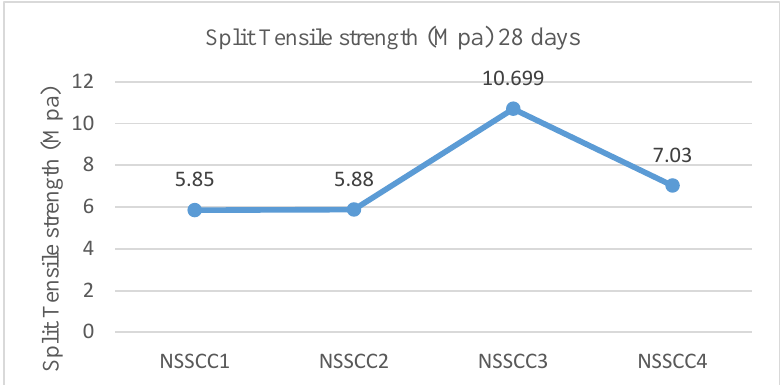
Fig. 22. Split Tensile Strength of NSSCC @ 28